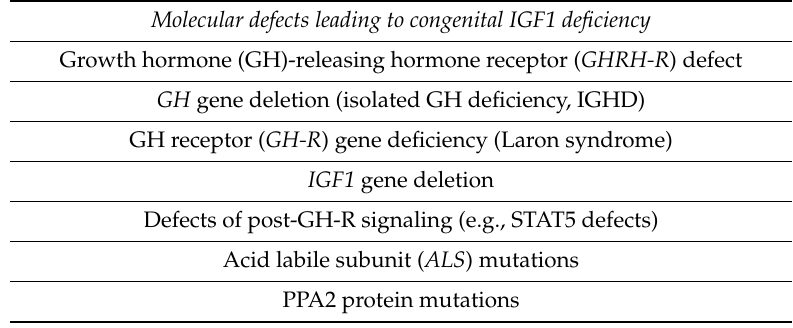
Table 1. Molecular pathology of congenital insulin-like growth factor 1 (IGF1)